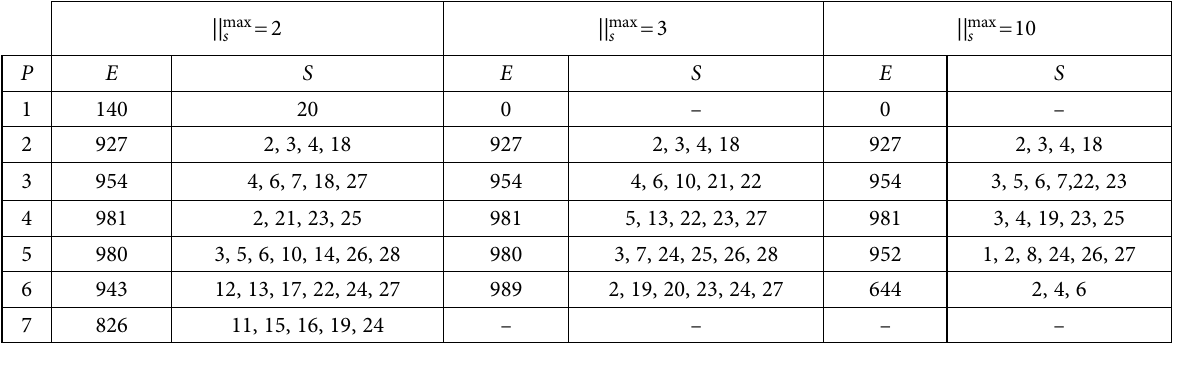
Table 17. The plan of expansion activity considering